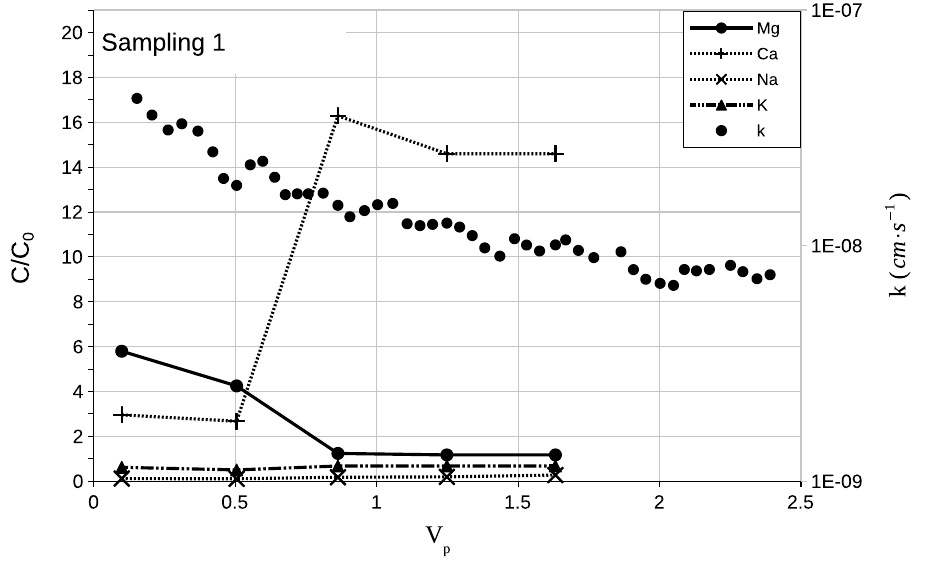
Figure 3. C / C 0 Breakthrough curves for cations and